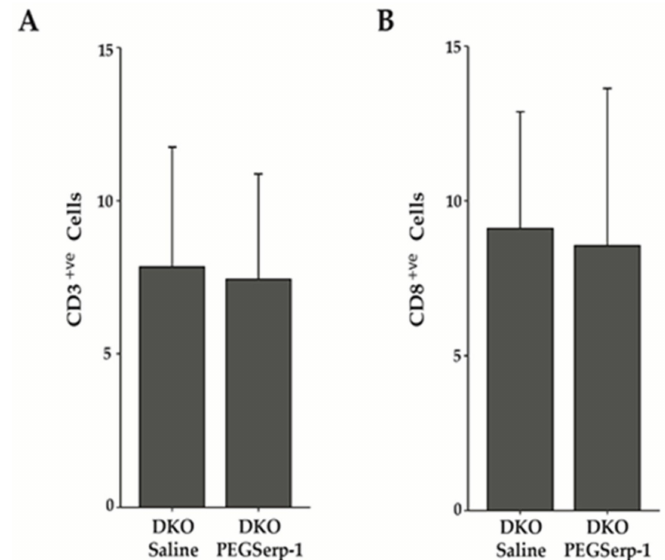
Figure 5. PEGSerp-1 does not alter CD3+ve or CD8+ve T cell infiltration. The presence of CD3+ve and CD8+ve T cells was assessed in the diaphragms of DKO mice treated with PEGSerp-1 and saline using IHC with an anti-CD3 antibody or anti-CD8 antibody. ( A ) The average number of CD3+ve T cells in PEGSerp-1- and saline-treated DKO diaphragms was determined. ( B ) The average number of CD8+ve T cells in PEGSerp-1- and saline-treated diaphragms was determined. Data are presented as average positive cells per field ± s.d., p = 0.